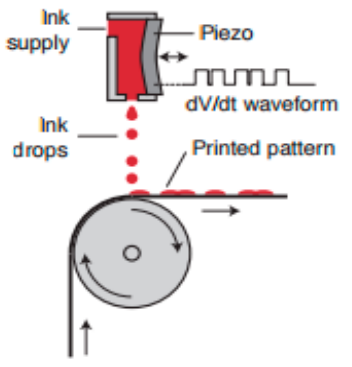
Figure 1. Simplified schematics of drop-on-demand piezoelectric inkjet. Reprinted with permission from [4].